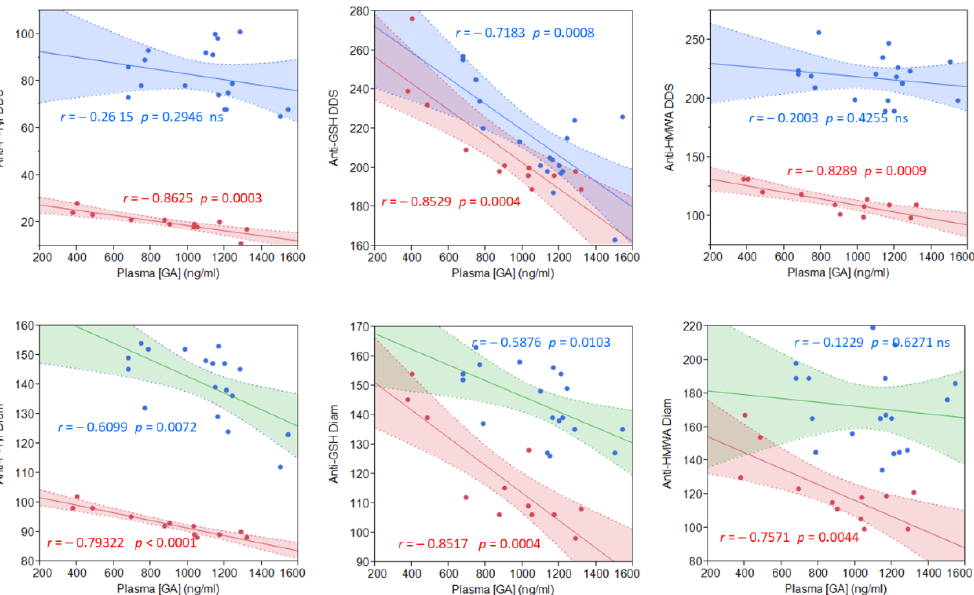
Figure 4. Correlation between the plasma GA concentration and measured parameters, after 1-week of licorice treatment, in both CG (red points) and PG (blue points) groups. Upper graphs: stimulation with DDS-NHOH. Lower graphs: basal values (not stimulated). For each regression line, Pearson’s correlation coefficient r is indicated, together with the corresponding p -value. To obtain the plasma GA concentration, an HPLC–MS full scan method was used as described in the Methods.